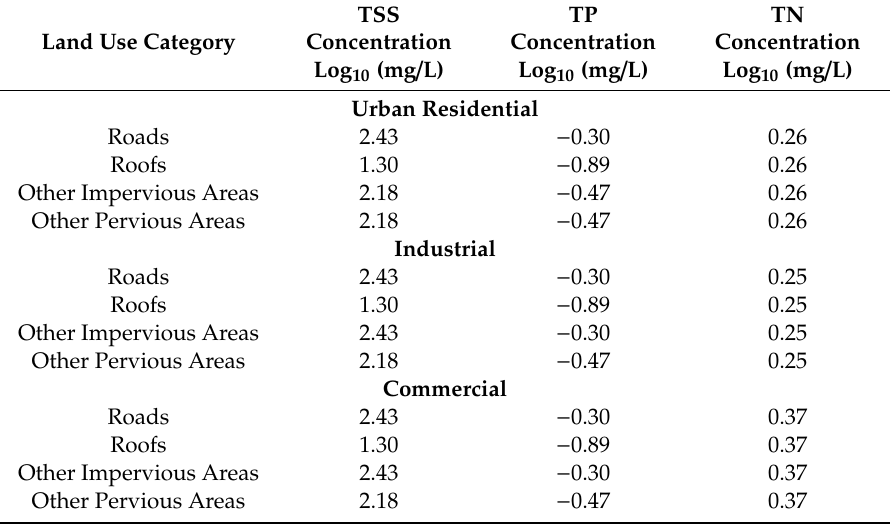
Table A7. MUSIC Storm flow mean concentrations for South East Queensland (Log 10 Values)